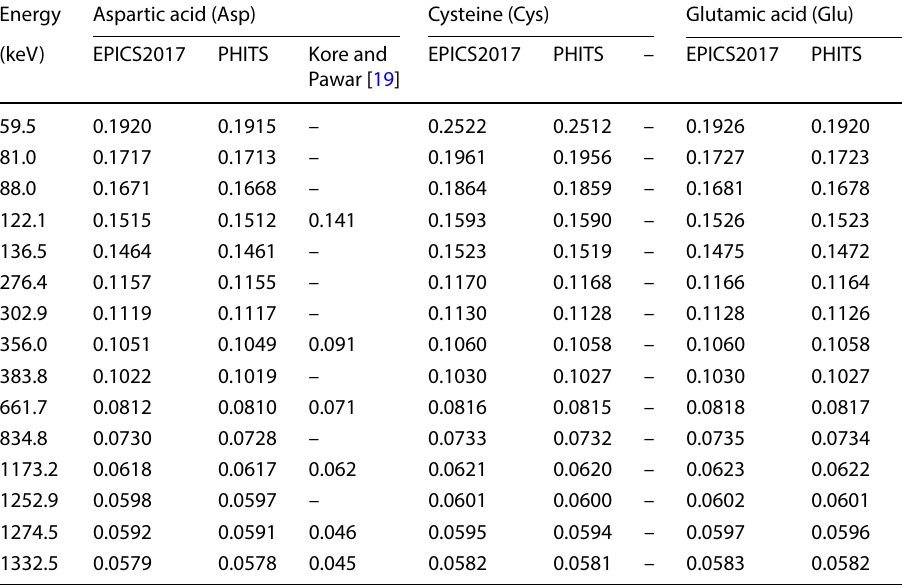
Table 3 Mass attenuation coefficients ( cm 2 g − 1 ) of aspartic acid, cysteine, and glutamic